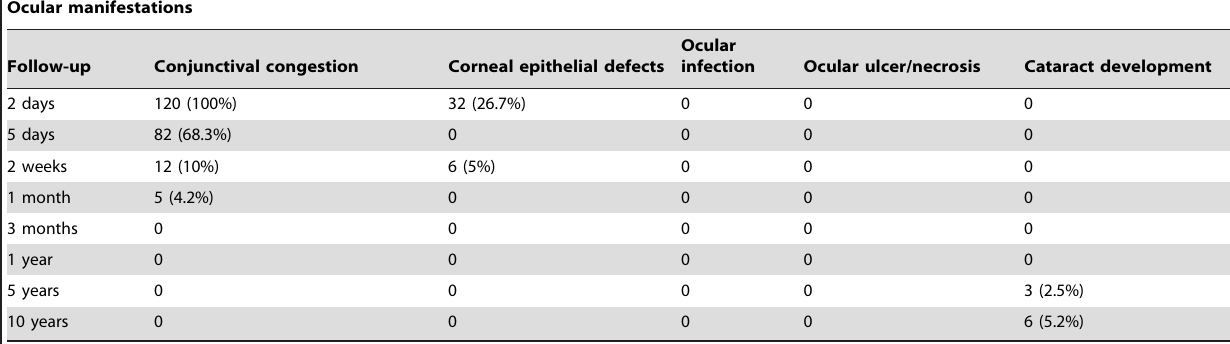
Table 1. Number of eyes (%) with different ocular manifestations in the follow-ups.